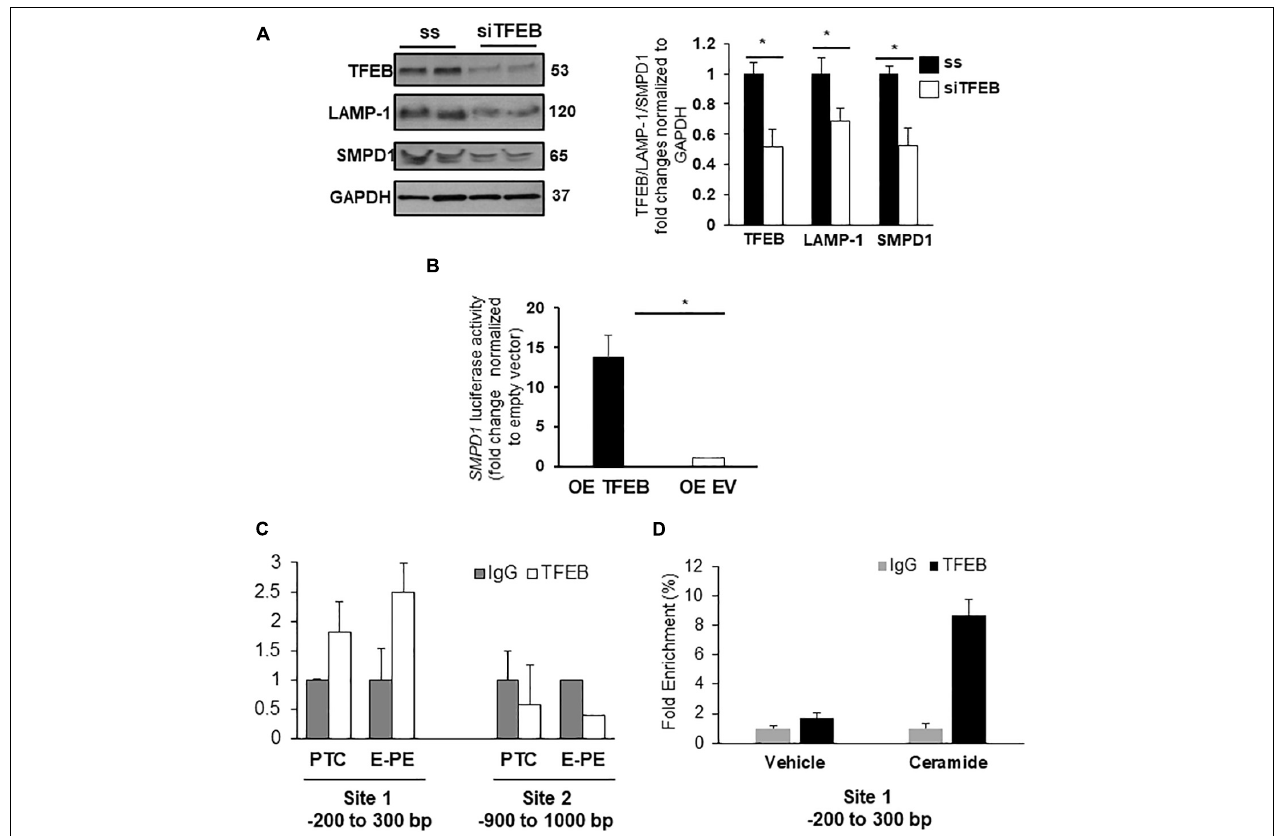
FIGURE 5 | SMPD1 is a direct target gene for TFEB. (A) Western blots and densitometric analysis of TFEB, LAMP-1 and SMPD1 in JEG3 cells following transient transfection with TFEB siRNA or a control (ss) scrambled sequence ( N = 3 separate experiments run in duplicate; * P < 0.05 compared to ss control). (B) Luciferase reporter assay showing SMPD1 expression in JEG3 cells following overexpression of TFEB (OE TFEB) or empty vector (OE EV). ( N = 3 separate experiments; * P < 0.05 compared to empty vector control). (C) qPCR of SMPD1 promoter regions –200 to 300 bp and –900 to 1,000 bp after chromatin immunoprecipitation with TFEB in E-PE and PTC placentae ( N = 4 for each group). (D) qPCR of SMPD1 promoter region –200 to 300 bp after chromatin immunoprecipitation with TFEB in JEG3 cells exposed to 20 µ M CER16:0 or EtOH